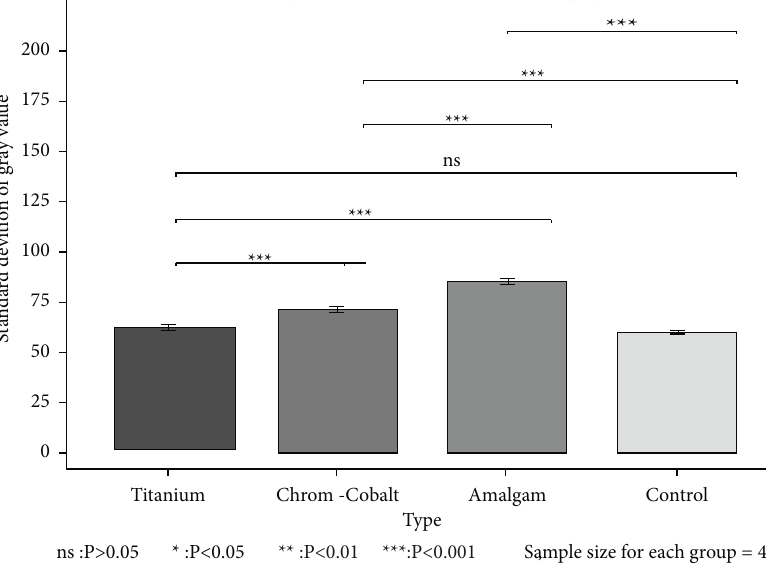
Figure 4: Pairwise comparisons of different metal objects regarding their effect on the SD of